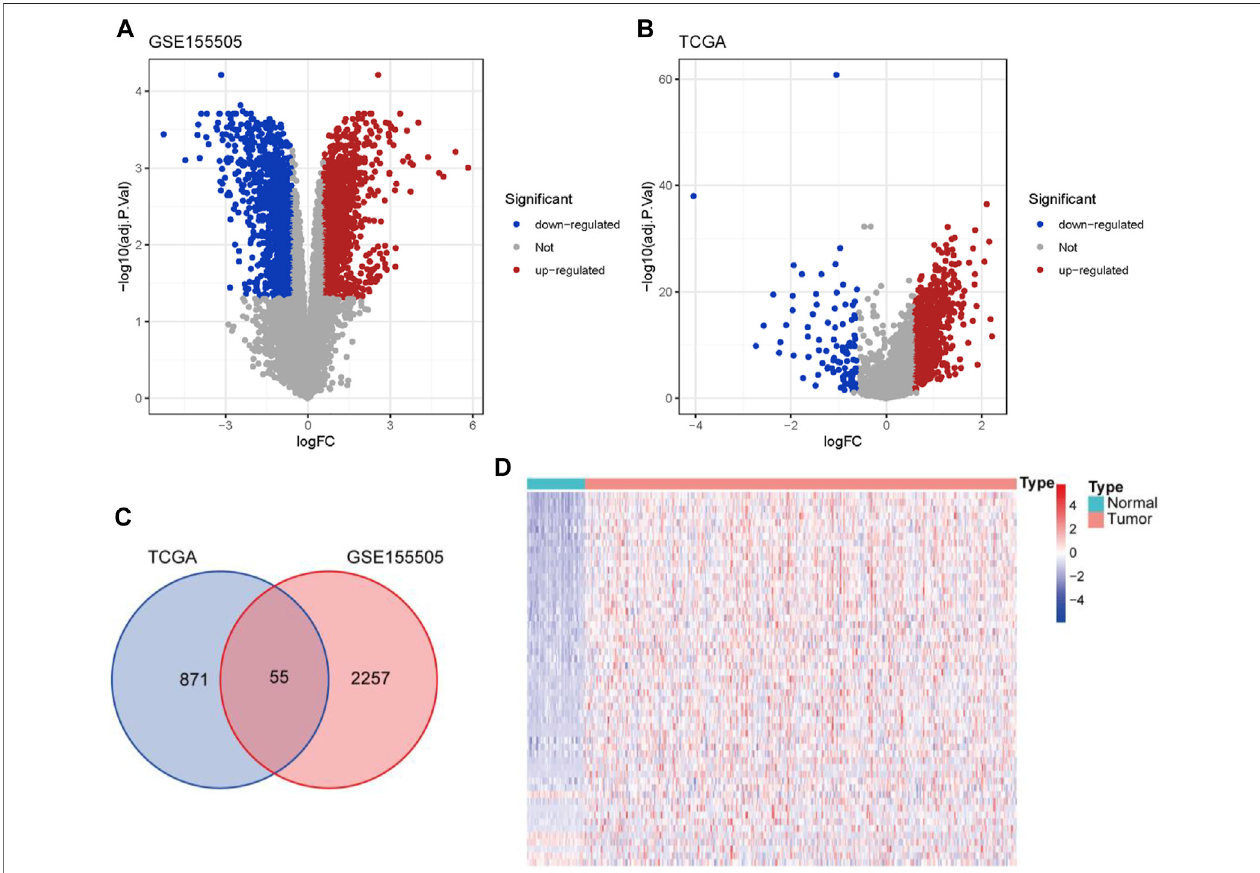
FIGURE1| Identi fi cationofHRDELsinHCC.Volcano plotsforDELsinGSE155505 (A) andTCGA-LIHCcohort (B) . (C) Venndiagramofhypoxia-relatedlncRNAs fromGSE155505andTCGA-LIHCcohort. (D) Heatmapoftheexpressionlevelsof55HRDELsbetweenHCCtumor andadjacentnormaltissuesinTCGA-LIHCcohort. HRDELs: hypoxia-related differentially expressed lncRNAs. DELs: differentially expressed lncRNAs. HCC: hepatocellular carcinoma. TCGA: The Cancer Genome Atlas. LIHC: liver hepatocellular